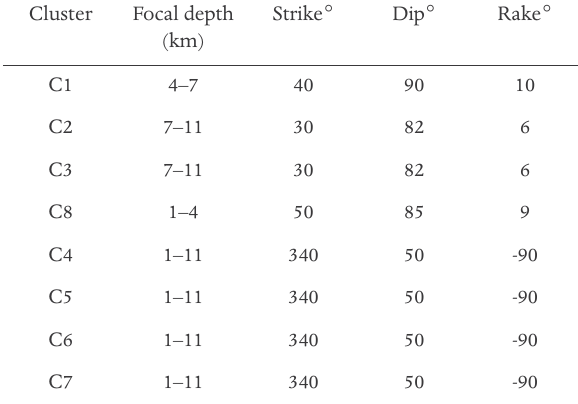
Table 2. Source parameters for various earthquake clusters in the Koyna-Warna seismic region (after Sharma